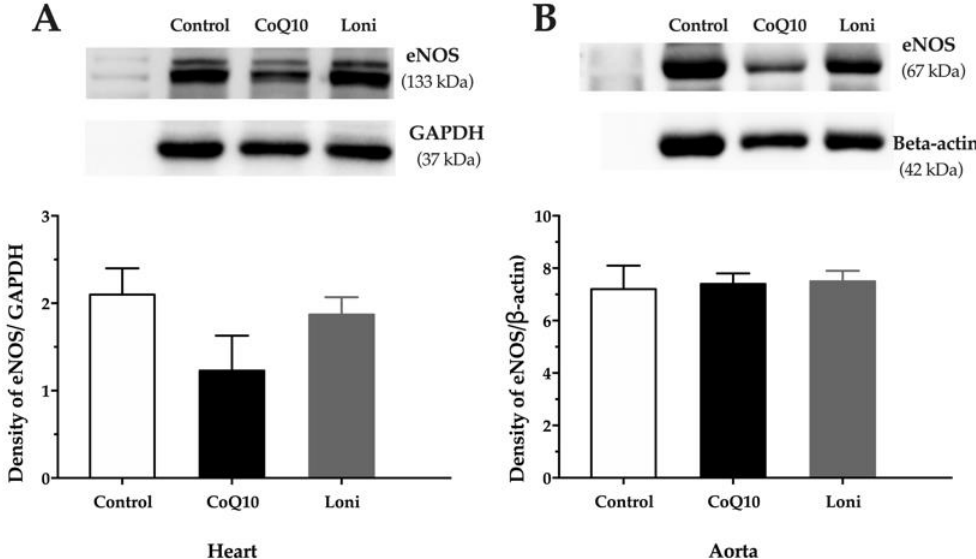
Figure 2. eNOS protein expression in the heart ( A ) and aorta ( B ). CoQ10; coenzyme Q10, Loni; Lonicera caerulea L. Heart; F (2.15) = 1.4312, p = 0.26986; aorta; F (2.15) = 0.04720, p = 0.95404. Data are means ± SEM from 6 animals in each group.